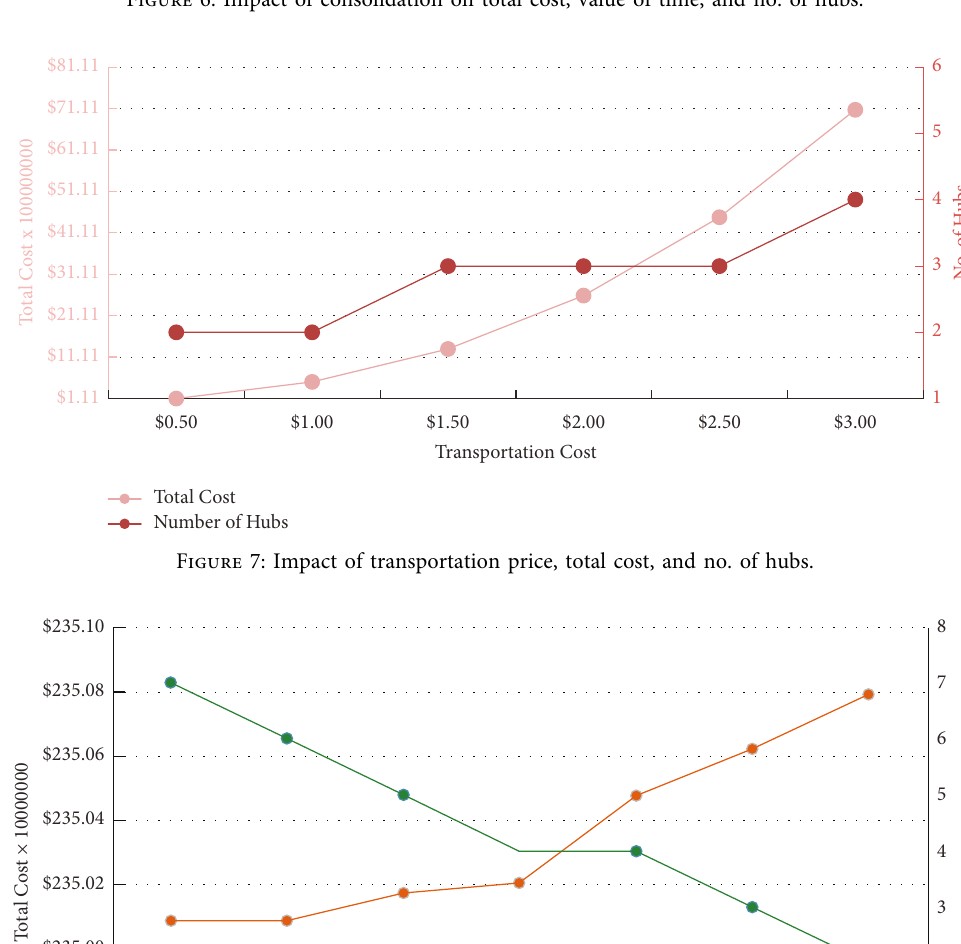
Figure 6: Impact of consolidation on total cost, value of time, and no. of hubs.